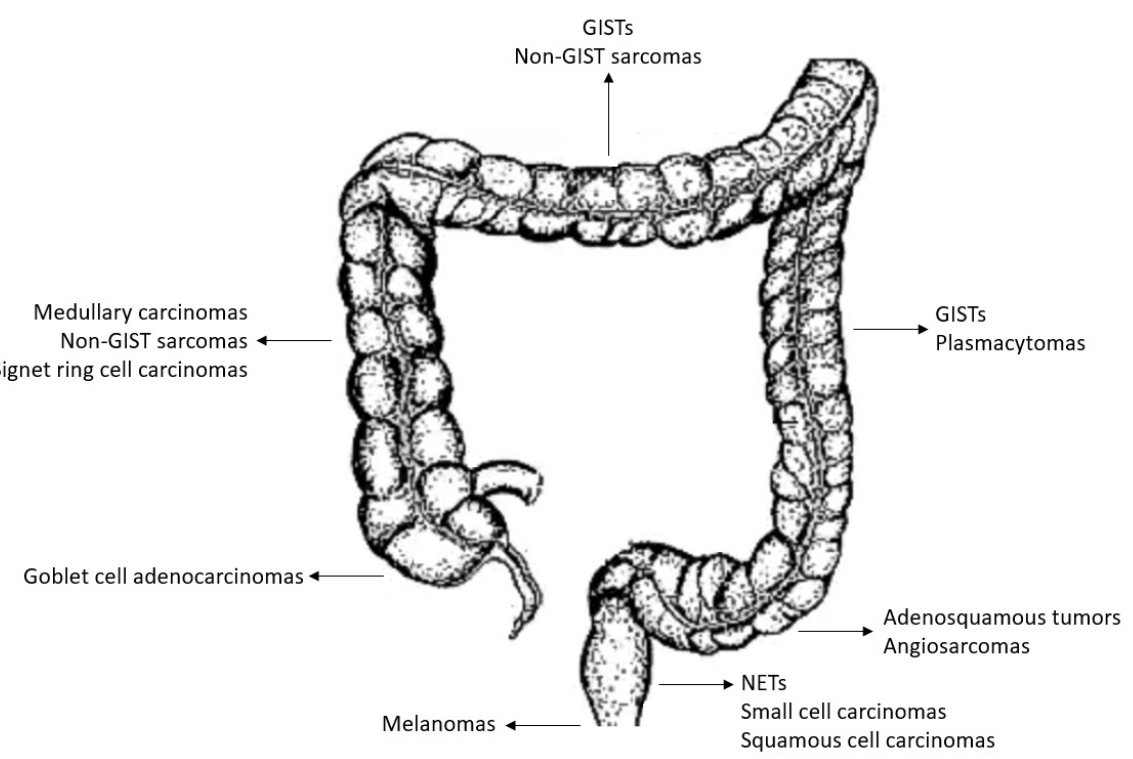
Figure 2. Anatomical site representation of predominant localization (as derived from the analysis of the clinical series analyzed in the present work).